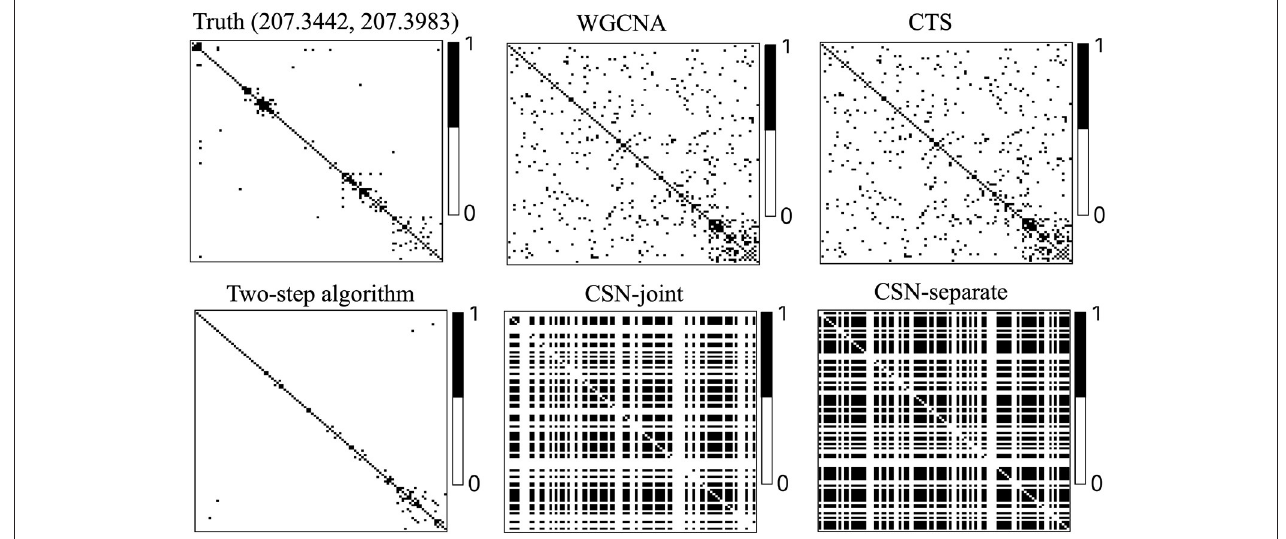
FIGURE 3 | Heatmaps of estimated gene co-expression networks for different methods and underlying truth. The network heatmaps of the cell on location (207.3442, 207.3983) was used for illustration.